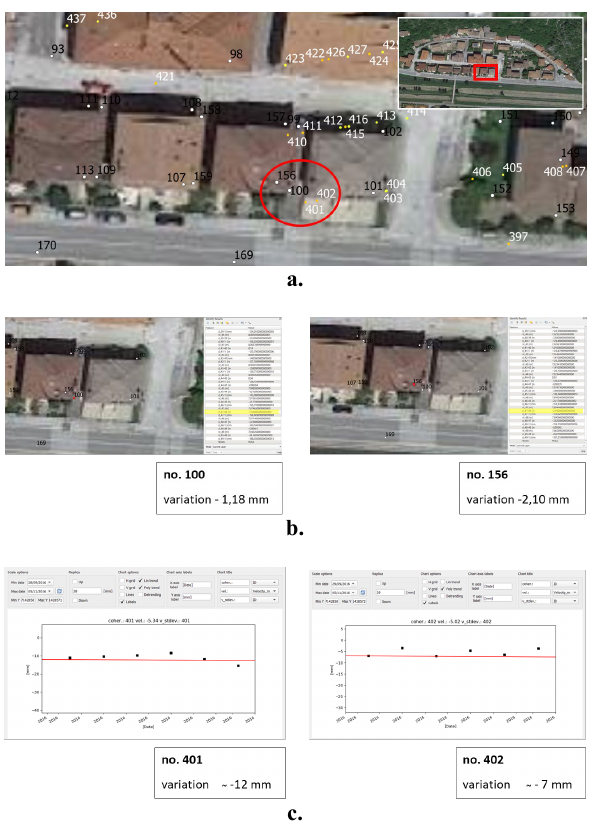
Figure 13. Post-seismic pointwise analysis between “moving points”. a. Identification of points on map; b. Points from topographic levelling c. Points from